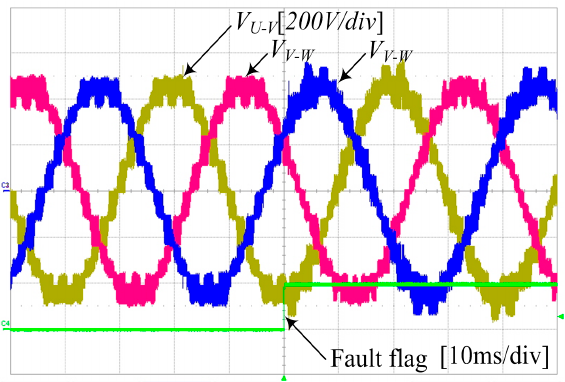
Figure 27. Experimental waveform of line-to-line voltage applying conventional neutral-point voltage-shifting control.